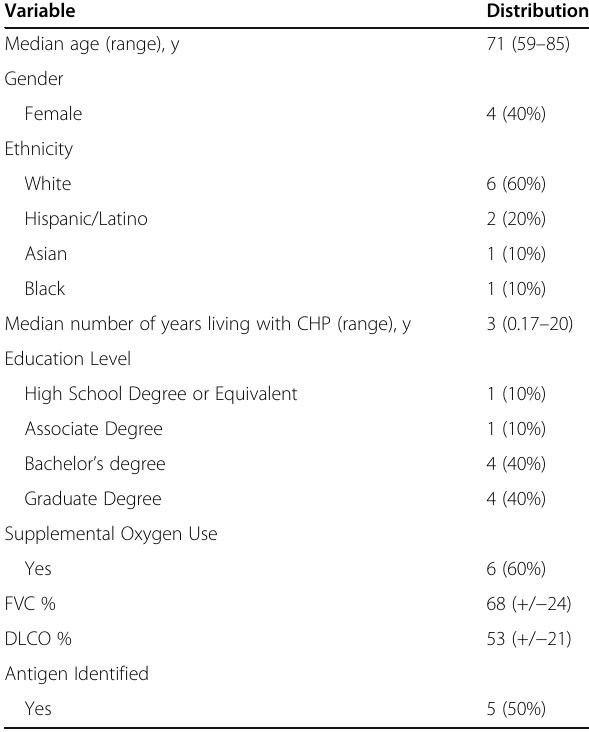
Table 1 Participant characteristics